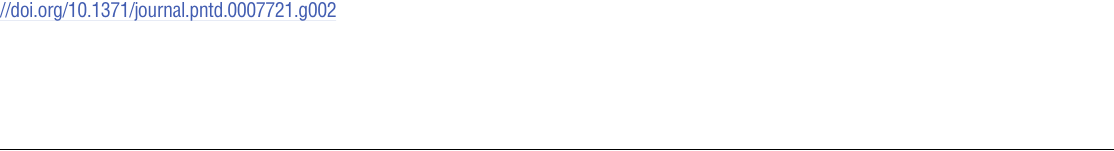
PLOS NeglectedTropical Diseases | https://doi.org/10.1371/journal.pntd.0007721 September 23,